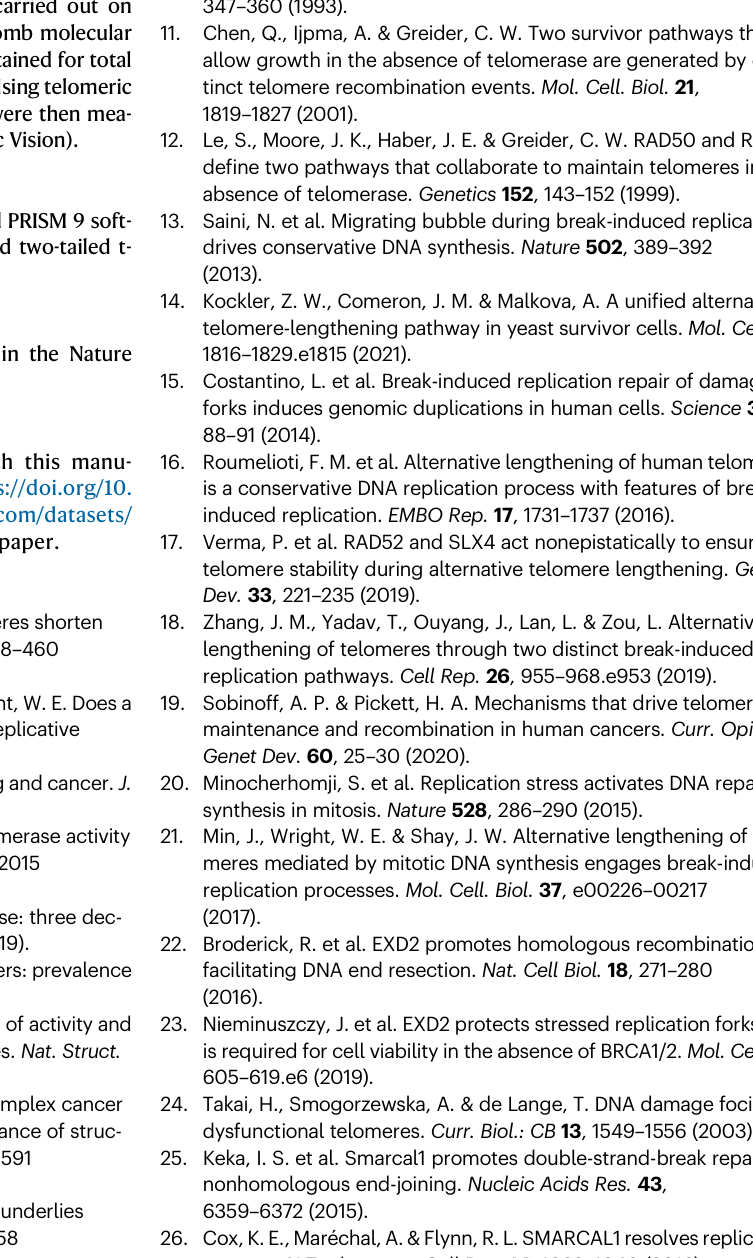
sidedstudent ’ st-test,barsrepresent+/ − SEM).Sourcedataareprovidedasasource data fi le. d